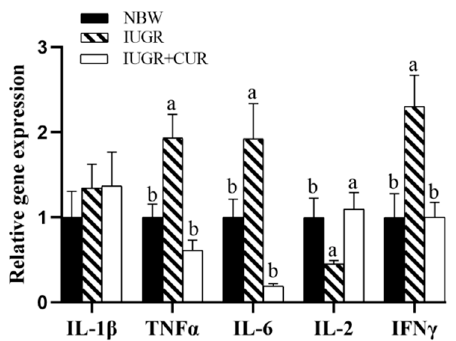
Figure 3. E ff ects of curcumin on immune-related gene expression: interleukin-1 β ( IL-1 β ), tumor